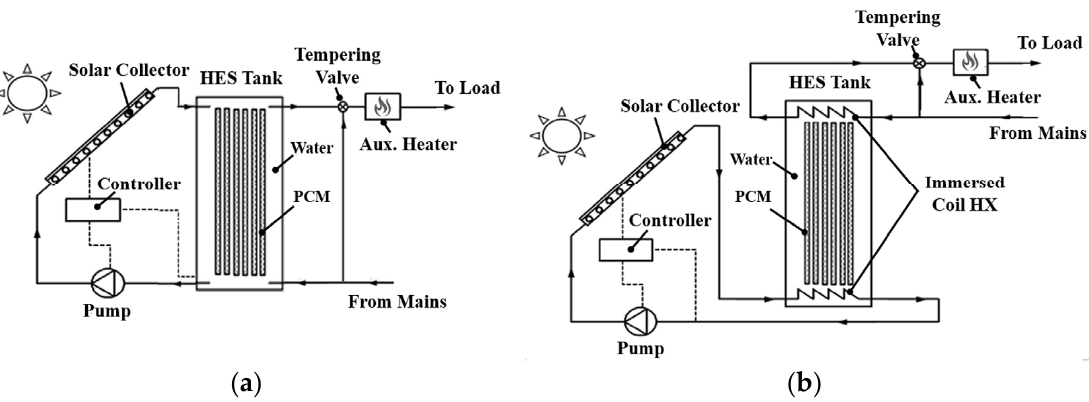
Figure 11. Schematic of ( a ) the storage unit and ( b ) the symmetric computational domain studied in [37].